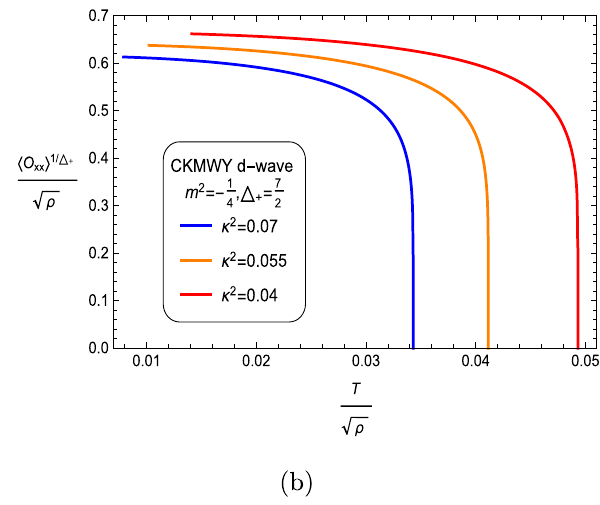
√ ρ = 0 . 0343 (blue: κ 2 = 0 . 07), √ / ρ = 0 . 0493 (red: c